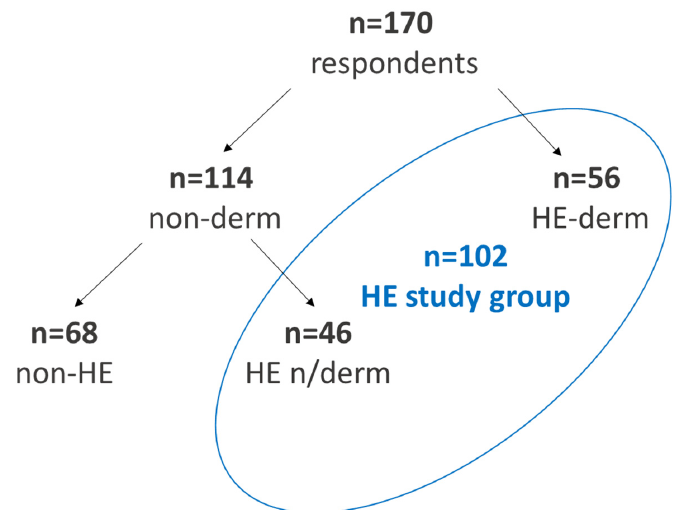
Figure 1. The division of study groups.